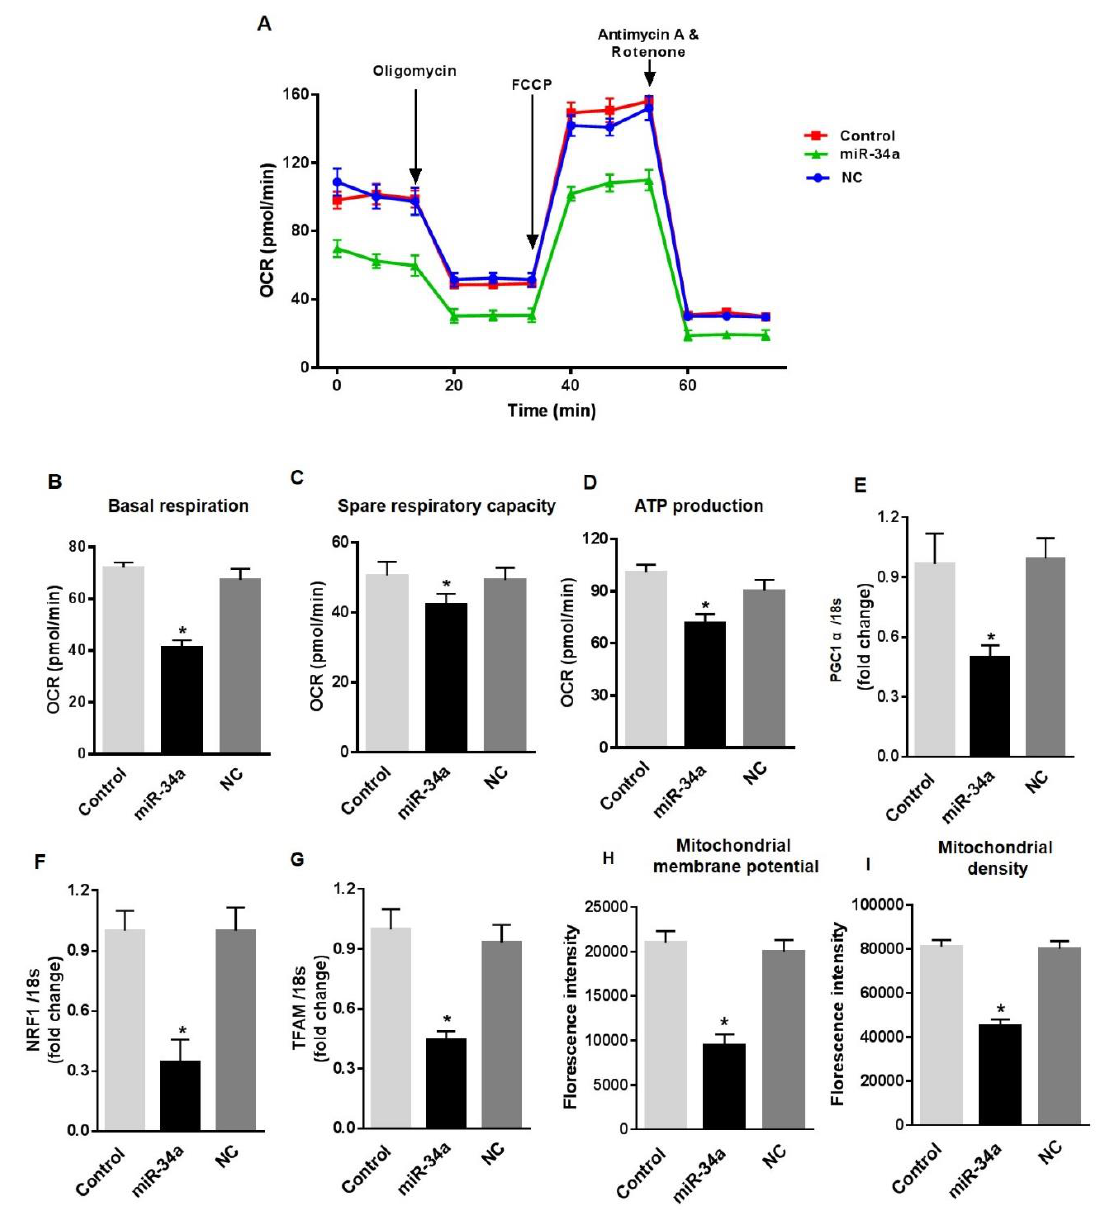
Figure 6. MiR-34a overexpression affects mitochondrial respiration and biogenesis, and induces senescence in HuREC. Mitochondrial function was assessed using the Seahorse XFp analyzer in HuREC transfected with 50 nM of miR-34a mimic (miR-34a) or negative control (NC) for 48 h. Non-transfected HuREC cells were used as control. Bar graphs of ( A ) OCR, ( B ) baseline, ( C ) spare respiratory capacity, and ( D ) ATP production in HuREC without transfection (light gray) or transfected with miR-34a mimic (black bar) or negative control (dark gray bar) for 48 h. ( E – G ) qPCR analysis assessing mRNA levels of genes regulating mitochondrial biogenesis: PGC-1 α , NRF-1, and TFAM. Bar histogram representing mRNA levels of ( E ) PGC-1 α , ( F ) NRF-1, and ( G ) TFAM genes in HuREC without transfection (light gray) or transfected with miR-34a mimic (black bar) or negative control (dark gray bar) for 48 h. FACS analysis assessing TMRE ( H ) and MitoTracker ( I ) dyes signals in HuREC without transfection (light gray) or 48 h after transfection with miR-34a mimic (black bar) or with negative control (dark gray bar). Bars represent mean value ± S.E.M; * p < 0.05 vs . Control or NC, n = 4.